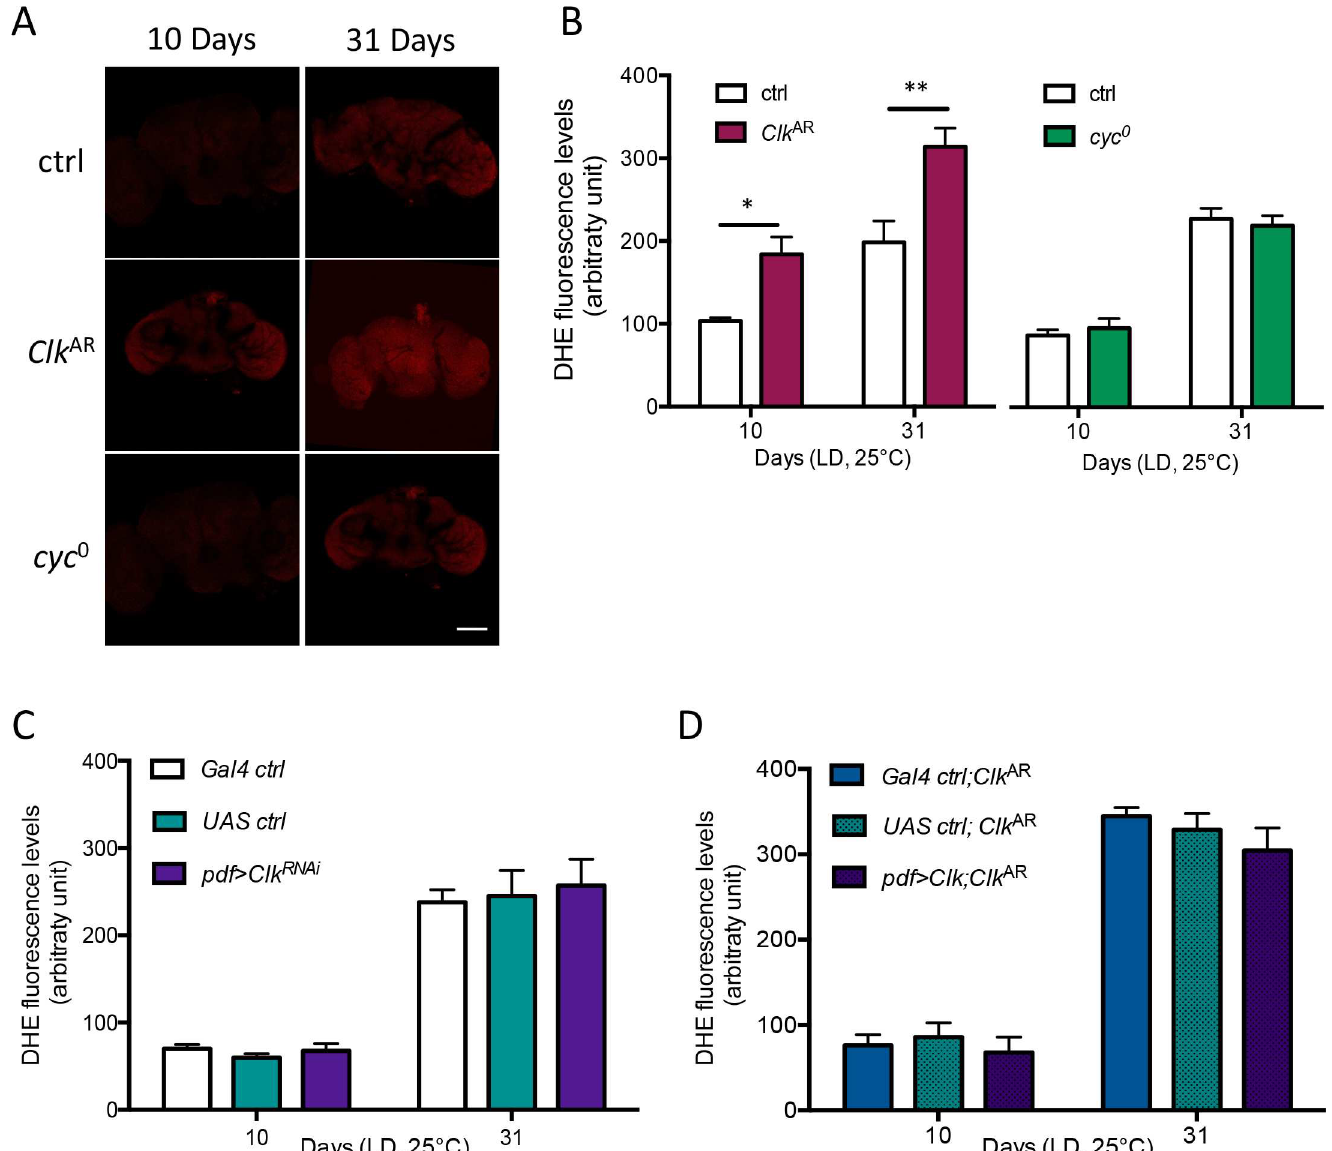
Fig 4. Clk regulates brain ROS levels independently from ARLI. (A, B) Brain ROS levels are higherin Clk AR mutants at both 10 and 31 days of age as comparedto ctrl and cyc 0 flies. Scale bars in A: 100 μ m.(C) Downregulating Clk expressionin the PDF neurons, which acceleratedARLI (see Fig 2A) had no effect on brain ROS levels as comparedto controls. (D) Brain ROS levels of Clk AR flies in which Clk expressionwas restored in the PDF neuronsonly, resulting in largely rescued ARLI (see Fig 3A), are unalteredin comparisonto respectivecontrols in the same Clk AR background. Histograms displaythe mean ± SEM of brain ROS levels from 2–3 independentexperiments with 6–8 brains per genotypein each